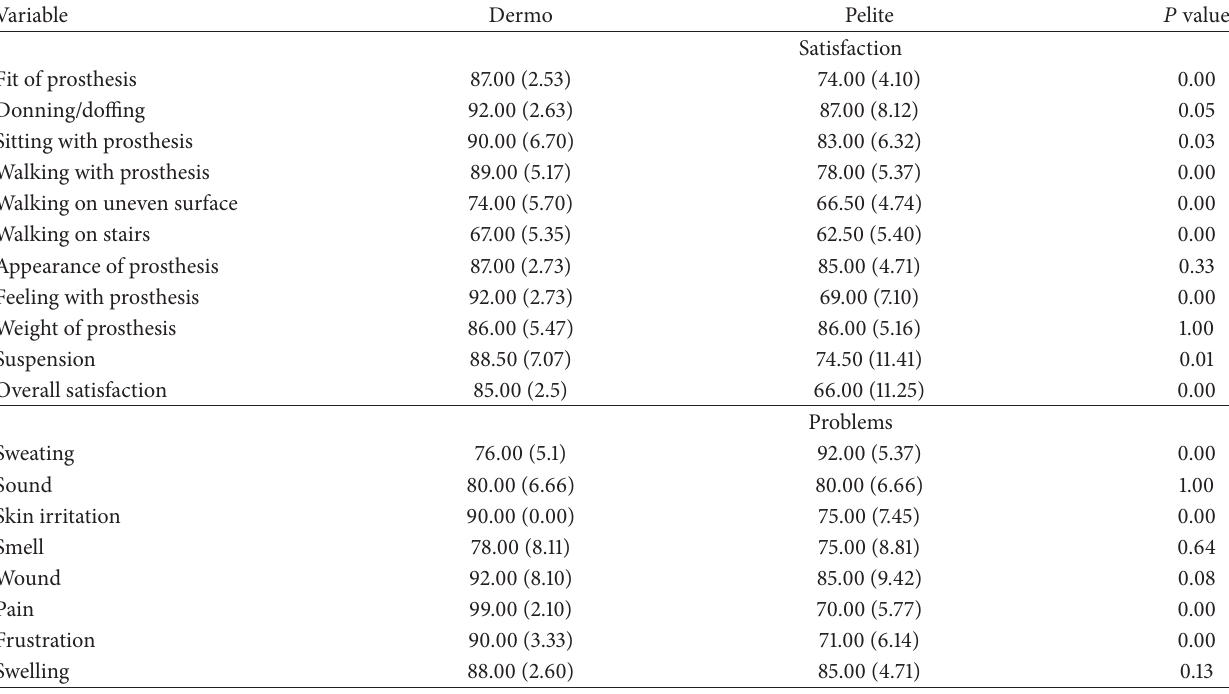
Table 4: Comparison between Dermo and Pelite